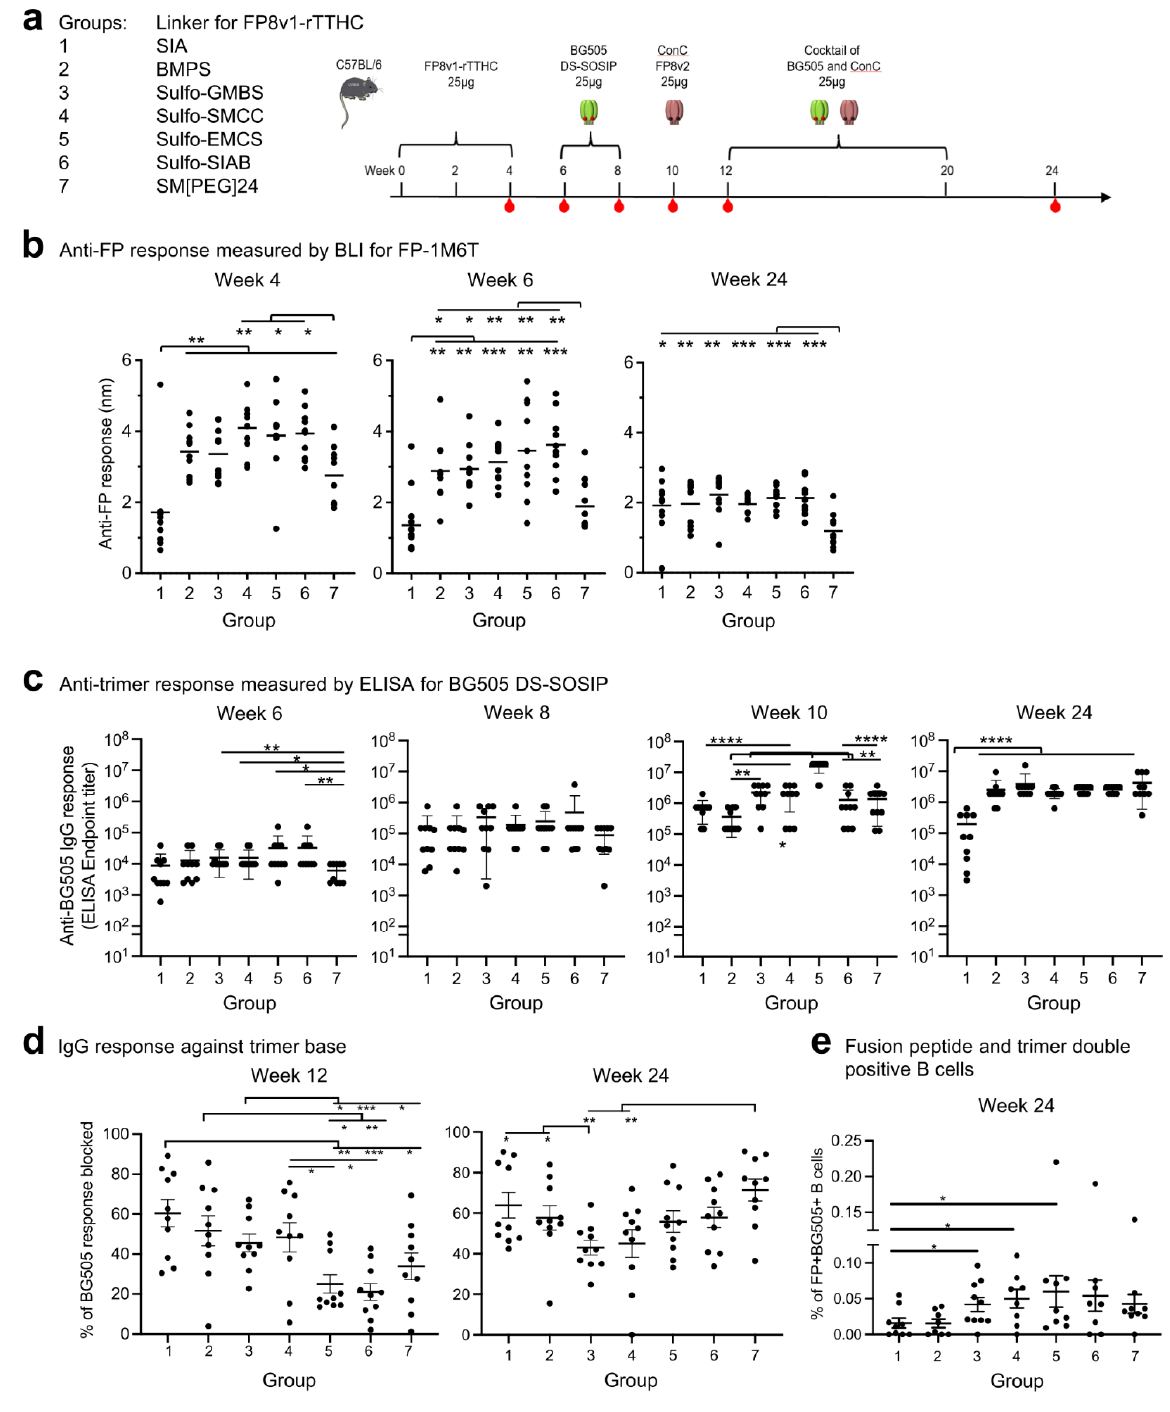
Figure 3. Immunogenicity assessments indicate linker for FP8v1-rTTHC influences antibody re- sponses. ( a ) Immunization regimen. Mice were immunized three times with an FP8v1-rTTHC immunogens and boosted with trimers using Adjuplex as adjuvant. Serum samples were taken at the indicated time points. ( b ) Anti-FP response measured by BLI responses to FP8v1 in the context of the 1M6T-scaffold (PDB: 1M6T). ( c ) Anti-BG505 trimer response. ( d ) Percentages of trimer base responses within total trimer response at week 12 measured by anti-base Fab19R competition assay. ( e ) Fusion peptide and trimer double-positive B cells from week. Two-tailed Mann–Whitney non- parametric tests were used for statistical analysis to assess p values for mean ± SEM. *: p < 0.05; **: p < 0.01; ***: p < 0.001; ****: p < 0.0001; ns, not significant.